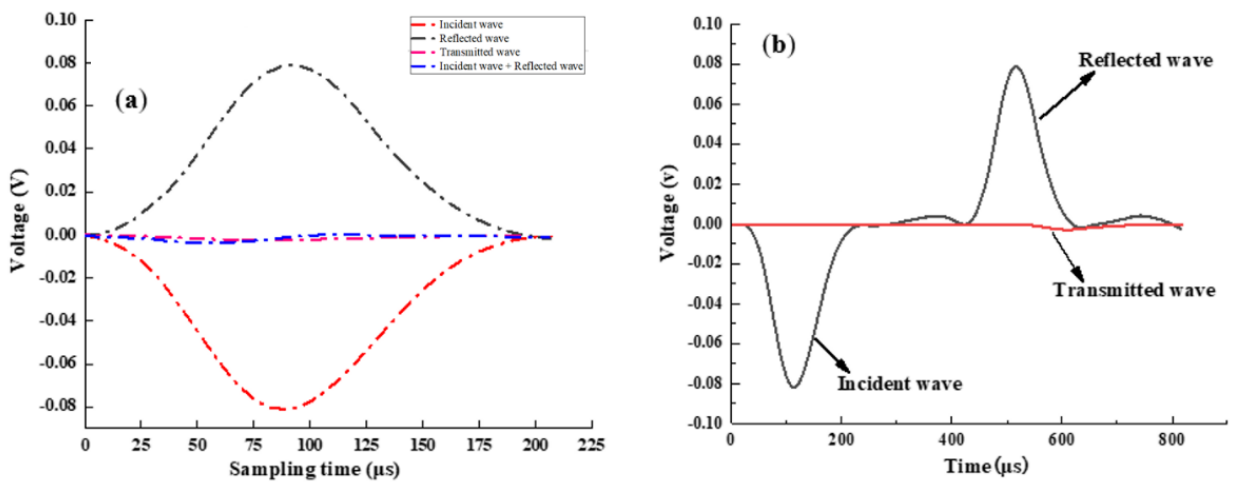
Figure 6. Voltage signal curve and stress balance test of a layered filling body: ( a ) stress balance test; ( b ) voltage signal curve.